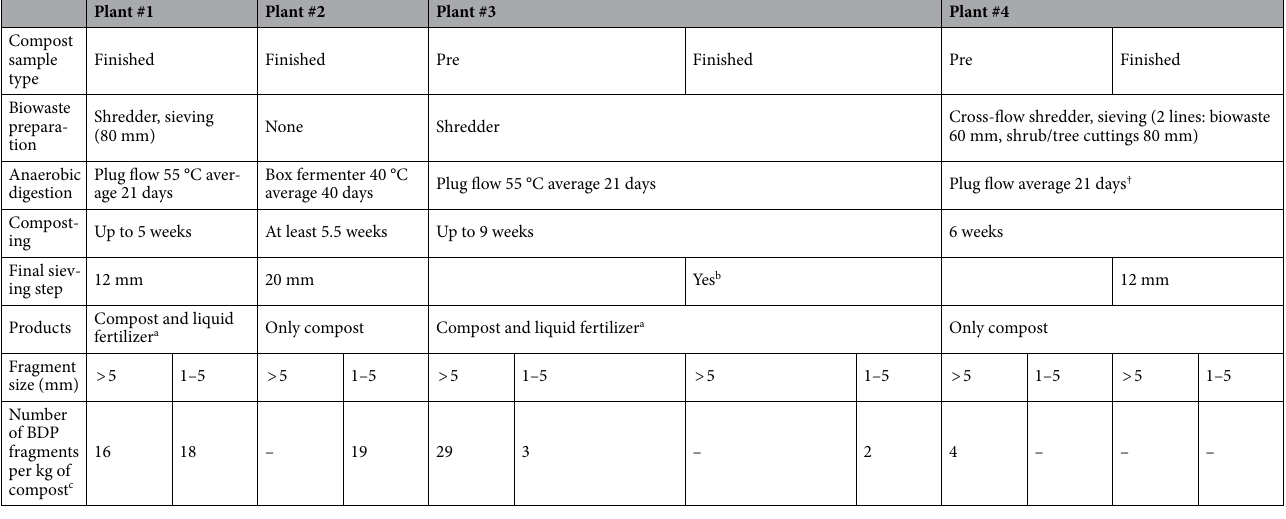
Table 1. Technical data of the investigated plants and incidence of BDP fragments in the sampled composts. a Part of the liquid fraction was returned into the fermenter for mashing the substrate. † One part of the digestate is dried and composted, another part is mixed with fresh substrate and returned to the fermenter. b No details available. c Dry